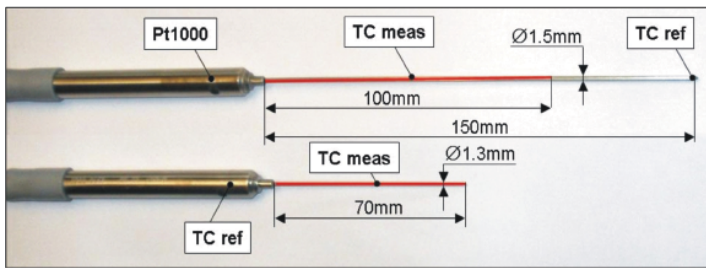
Fig. 2. The commercial TP02 (long needle) and TP08 (short needle) thermal conductivity probes produced by the Dutch company Hukseflux. The heated part is indicated in